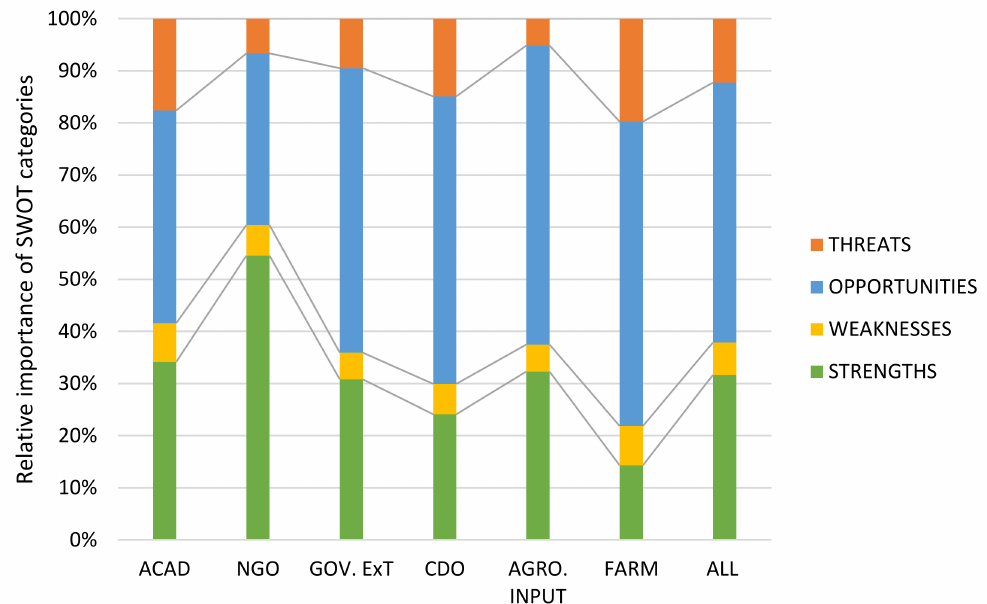
Figure 1. Stakeholder group perceptions of the importance of SWOT categories for the development of agronomic iodine biofortification in Uganda. ACAD: academic group; GOV.EXT: government extension group; CDO: Community Development Officers; AGRO.INPUT: agro-input company sample; FARM: elite farmers group; NGO, Non-Governmental